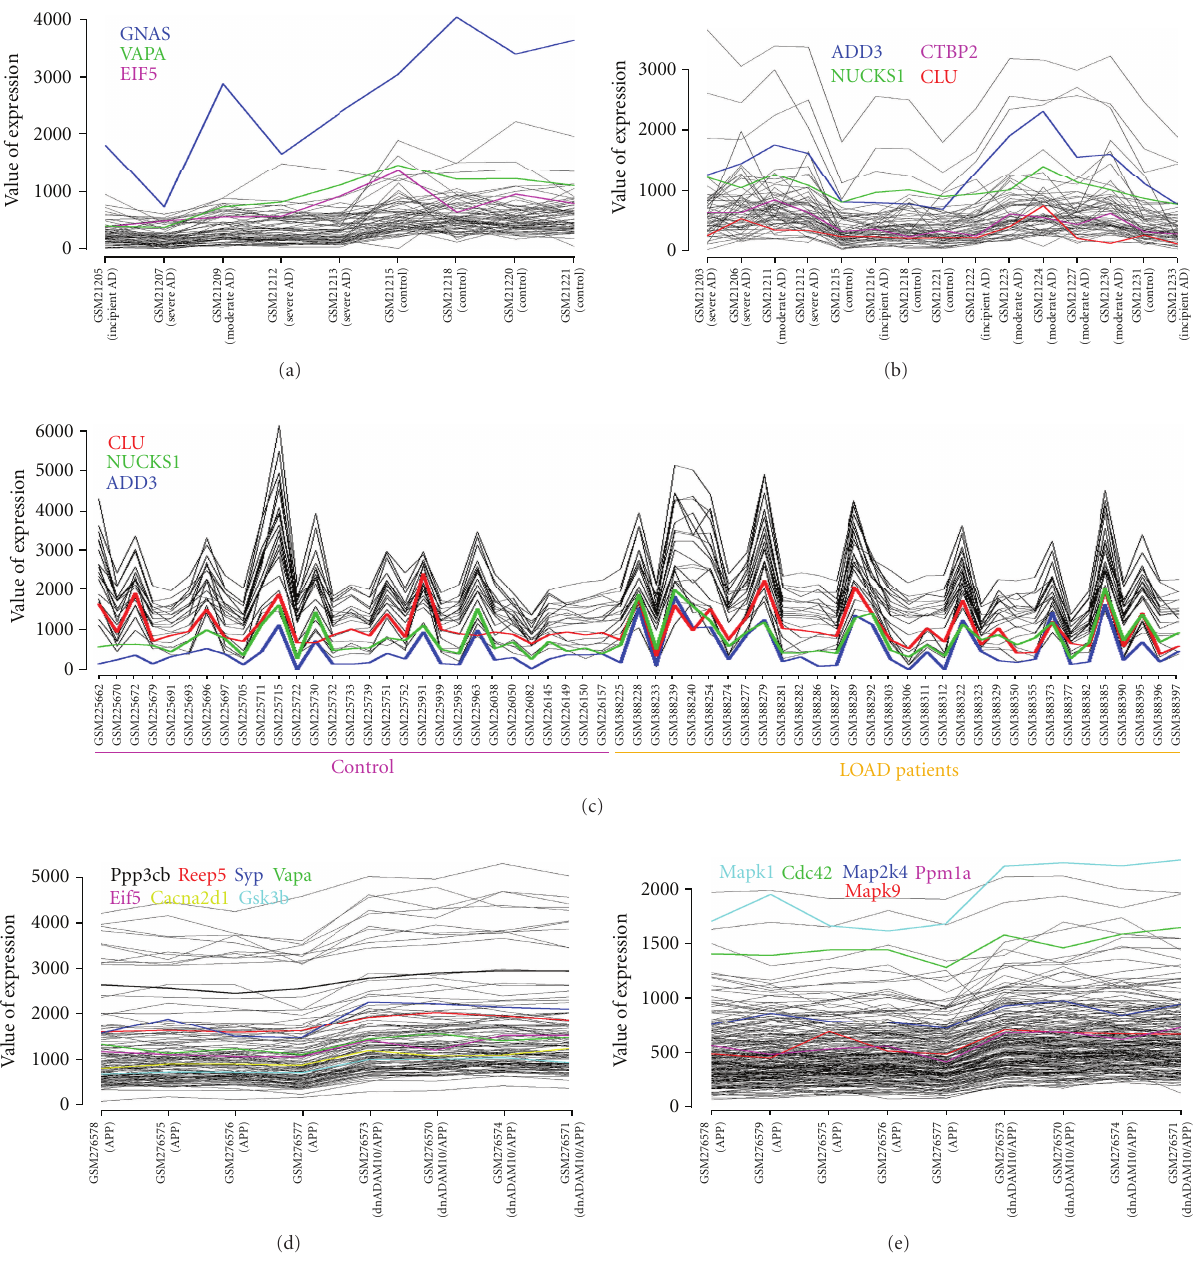
Figure 3: Expression profiles of five di ff erent clusters of coregulated genes. On the x -axis, the sample IDs (specified by accession numbers of GEO/NCBI) incorporated in the cluster are given, and y -axis indicates values of expression. One gene corresponds to a single line in the profile, and the target genes of the modules as mentioned in the text are coloured. The two upper profiles (a, b) are clusters of coregulated genes of the AD patients dataset, the profile in the middle (c) corresponds to coregulated genes of the LOAD patients dataset, and the two profiles below (d, e) correspond to coregulated genes of the double-transgenic mice dataset. The target genes of the profiles (a) and (d) were used for the establishment of the module CTCF-EGRF-SP1F and the profiles (b) and (e) for the module CTCF-SP1F-ZBPF, at which (b) was also used for the module KLFS-SP1F-ZBPF. The five lines in profile (e) correspond to genes, which are involved in the MAPK signaling pathway. The target genes of the profile (c) were used for the establishment of the modules CTCF-SP1F-ZBPF and